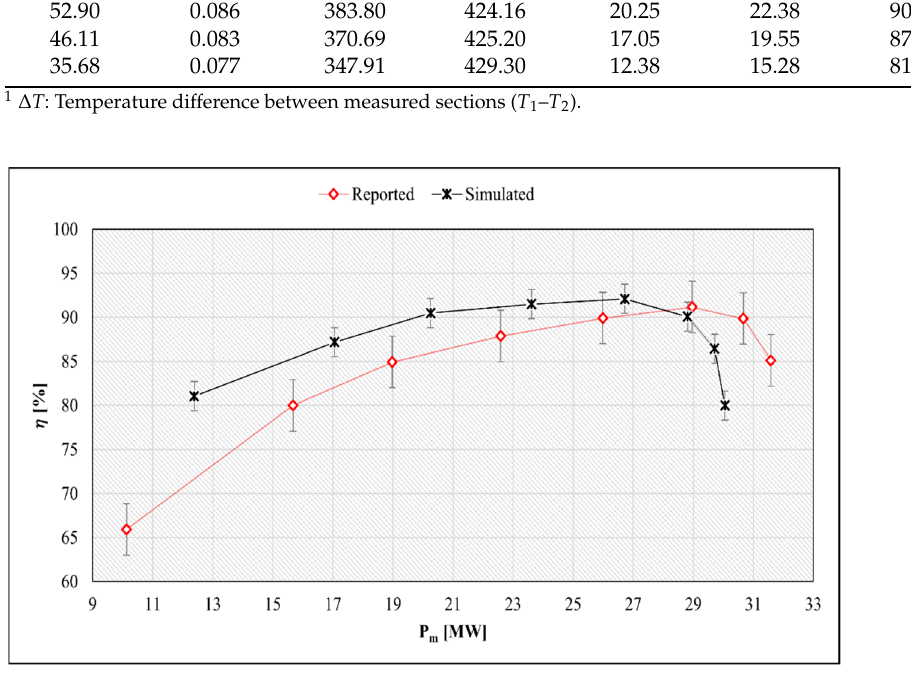
Figure 17. Comparison, Reported hydraulic efficiency (Gibson method) vs. Simulated hydraulic efficiency.